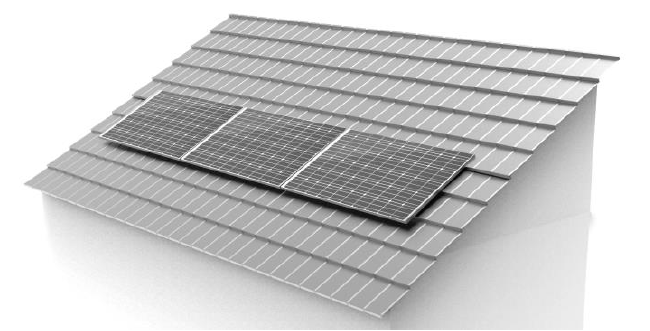
Fig. 8. Traditional 1 kWp installation on the roof.